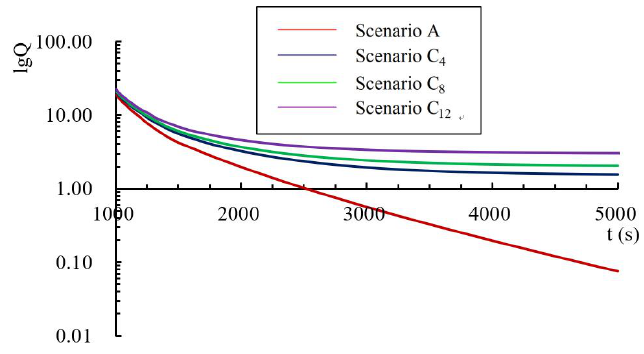
Figure 15. Recession curves of spring hydrographs with pumping at different wells.